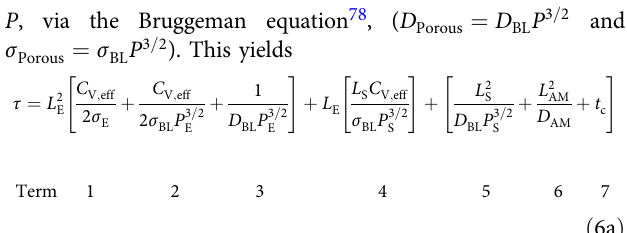
E σ fi ts in ( e ) with the legend giving M . This data is extracted from the